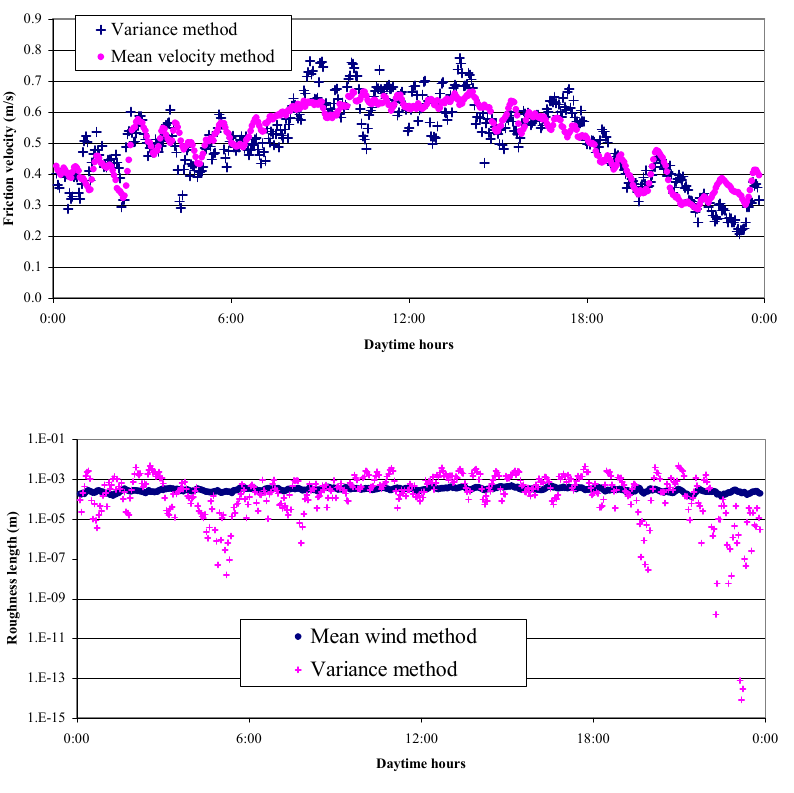
Fig. 7. Values of the roughness length. Comparison between the vari- ance (cross) and the mean wind meth- ods (dot), plot CT, 25 July 1997. The mean wind method data are from Richard